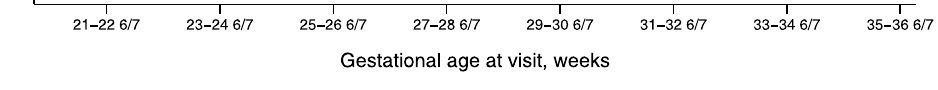
Fig 2. Mean percent adherence by gestational age at visit, n =